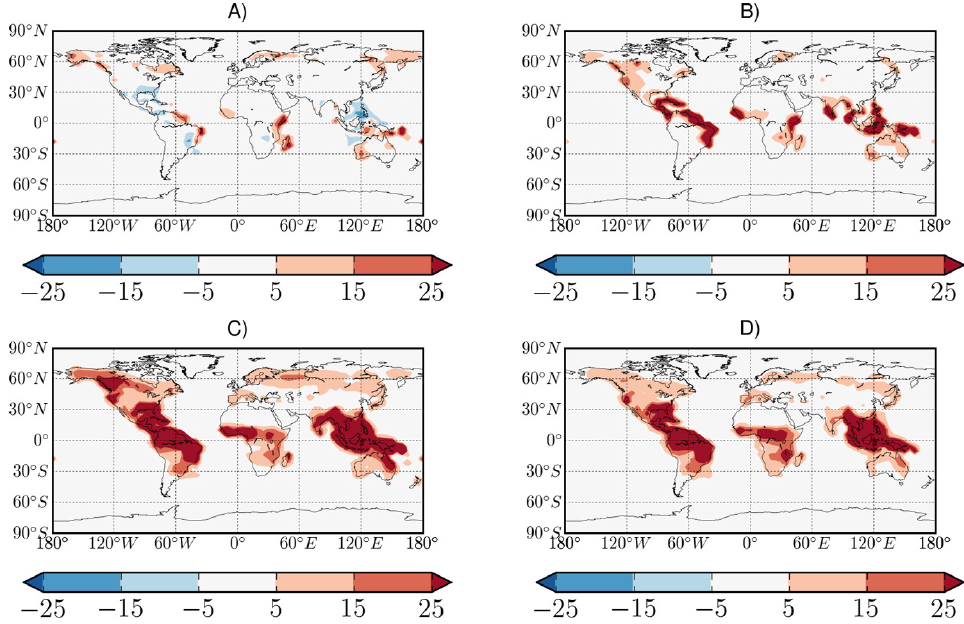
Fig. 9. Increases in aerosol number concentrations due to ultrafine aerosol growth by semi-empricial organic condensation scheme for June 2001. Changes in global aerosol number concentrations (average over 1km) if 50% of the total OA mass is distributed as effectively non-volatile, as compared with the case where it partitions to the pre-existing aerosol mass. The colorscale indicates percentage changes in number concentrations of particles > 3nm (A) , > 10nm (B) , > 40nm (C) , and > 80nm (D) .